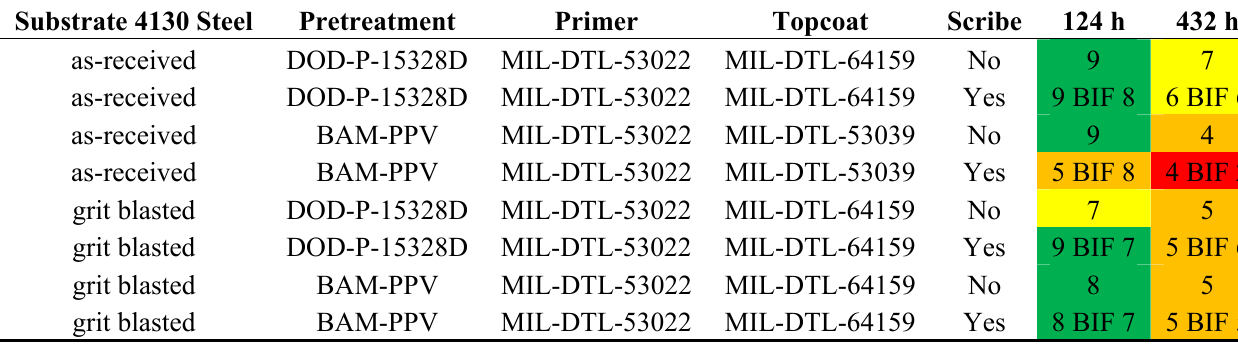
Table 4. ASTM D 1654 ratings for as-received and grit-blasted 4130 steel coupons in the neutral salt spray (NSS) chamber. BIF, blisters in